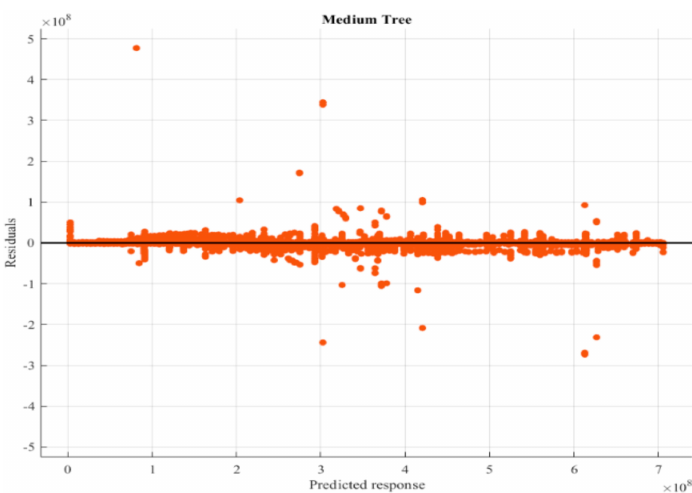
Figure 16. Medium Trees Residual